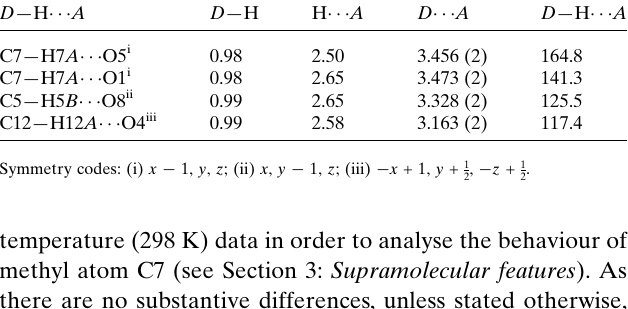
Table 1 Cremer–Pople ring-puckering parameters (A˚ , (cid:5) ) for I at 90 K. Pyran